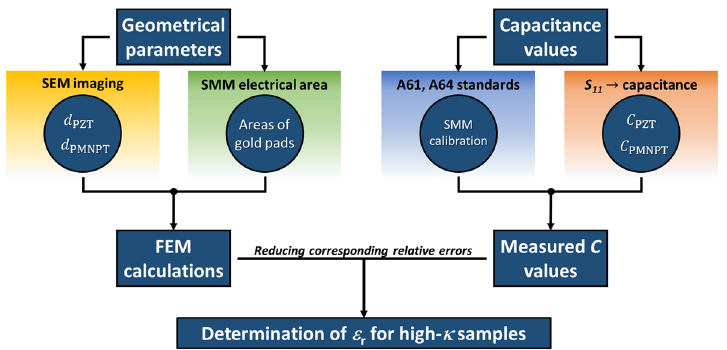
Figure 2. Schematic diagram describing the workflow steps of our measurement and simulation protocol for the determination of the dielectric constant of the high-κ samples. d and C denote the measured thickness and capacitance of the PZT and PMN-PT dielectric layers, respectively.